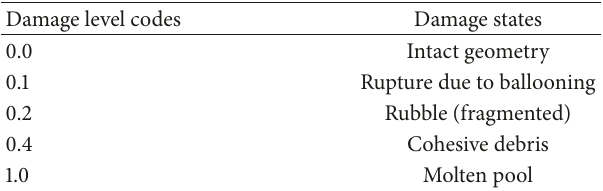
Table 2: Damage level states classified by the